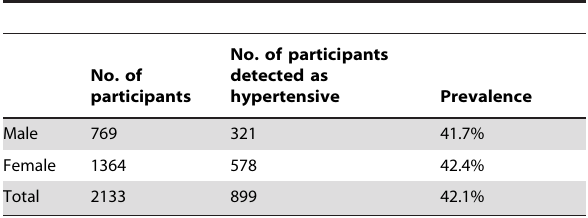
Table 1. Prevalence of hypertension among Bai people aged 50 or more in Dali, southwest China.